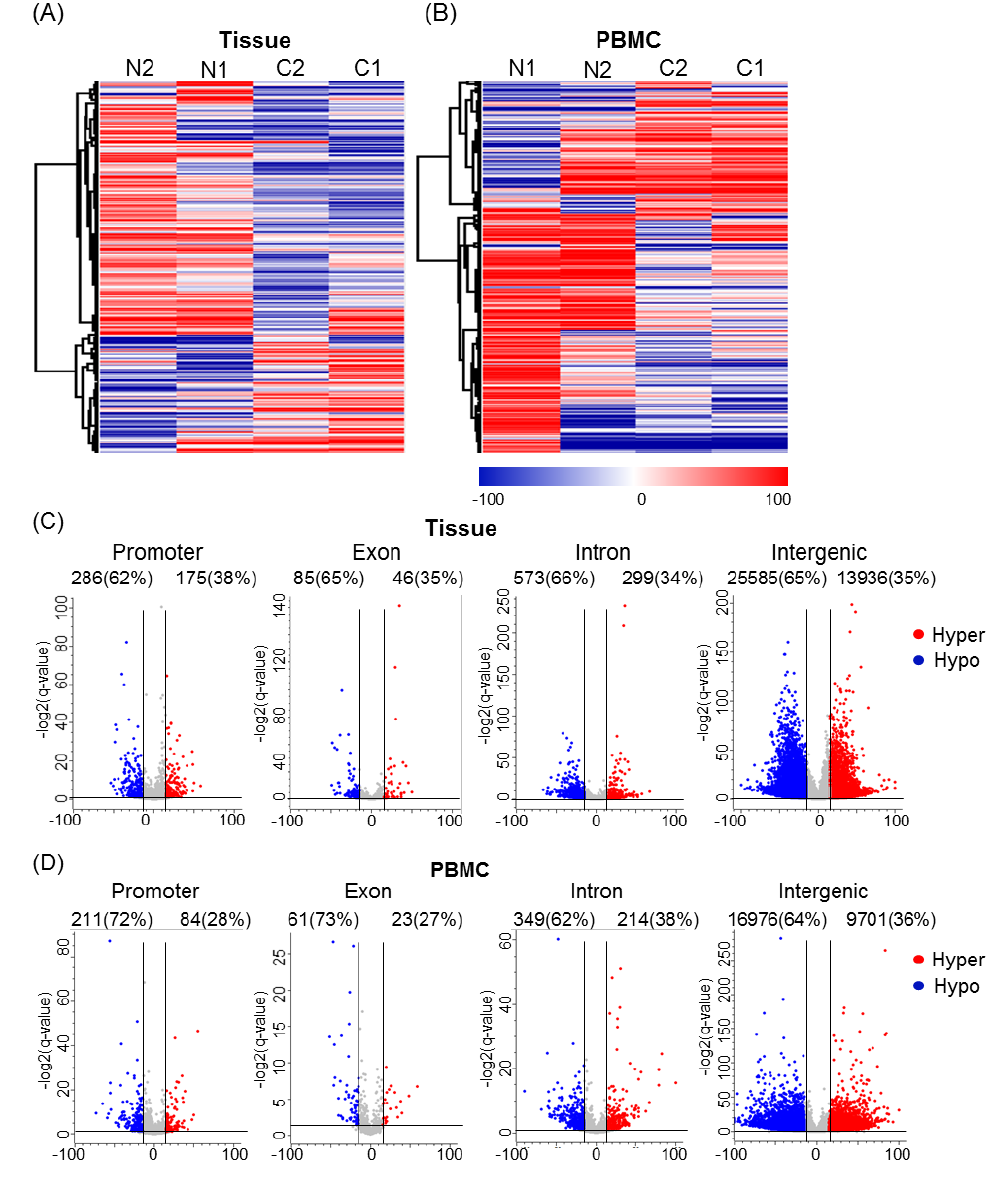
Figure 2. Genome-wide DNA methylation changes in CMT tissue and PBMCs. ( A , B ) Hierarchical clustering and heatmap of DMRs defined by difference ≥15%, false discovery rate (FDR)-adjusted q -value ≤ 0.05, and read coverage ≥10 in CMT tissues. The color indicates the percentage methylation: hyper (in red) and hypo (in blue). N: normal, C: CMT. Heatmaps for tissues ( A ) and PBMCs ( B ) were generated by complete linkage clustering using a Pearson correlation. ( C , D ) Volcano plots of all DMRs separated according to their genomic features. The x -axis represents methylation percentage and the y -axis represents −log2 ( q -value). Methylation changes in promoter, exon, intron, and intergenic regions were examined; DMRs are depicted as blue (hypo) or red (hyper) dots in CMT tissues ( C ) and PBMCs ( D ). CMT: canine mammary tumor; PBMC: peripheral blood mononuclear cells; DMR: differentially methylated region